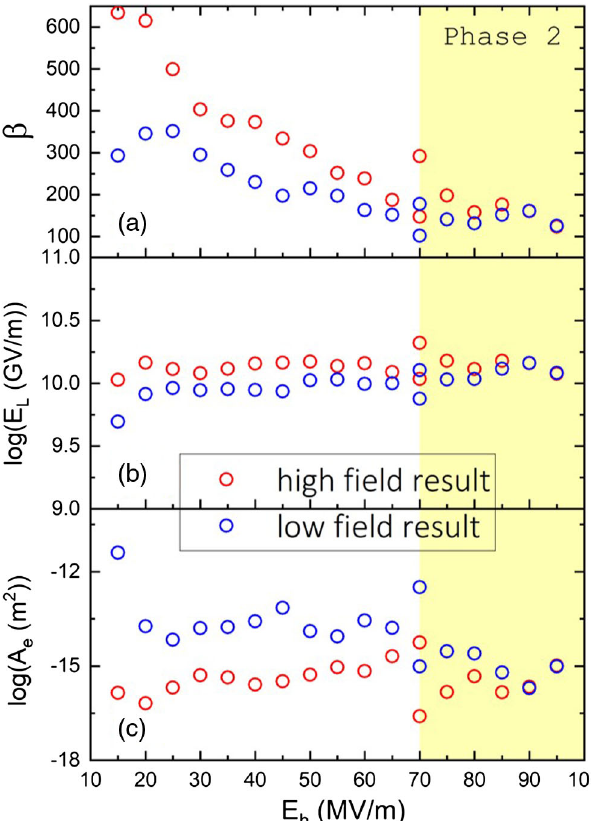
FIG. 7. Field emission conditioning parameters: (a) field en- hancement factor, (b) local field on the cathode surface, and (c) effective emission area for both the FN-like (low field) and non-FN (high field)